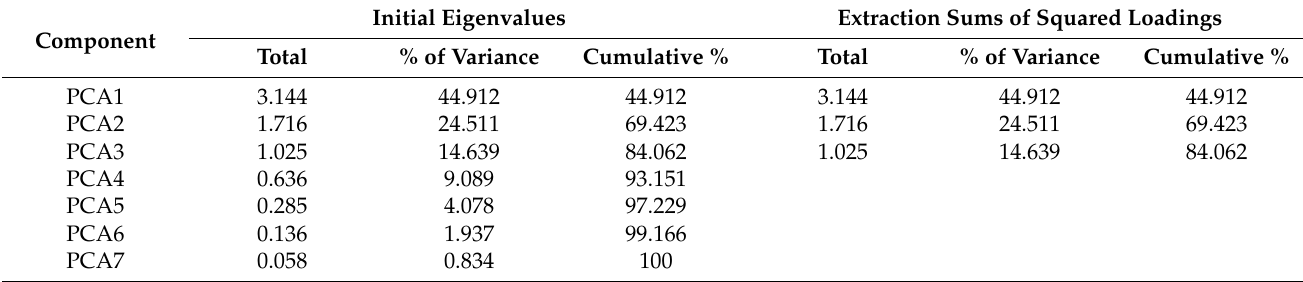
Table 3. Eigenvalue and contribution rate of seven test